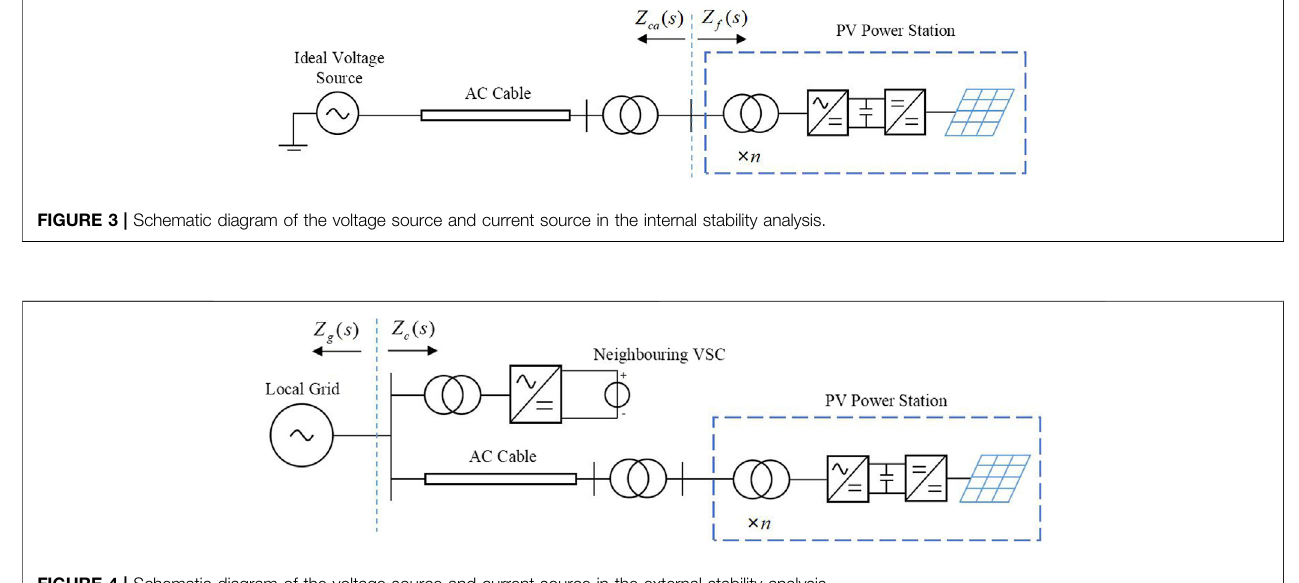
FIGURE 4 | Schematic diagram of the voltage source and current source in the external stability